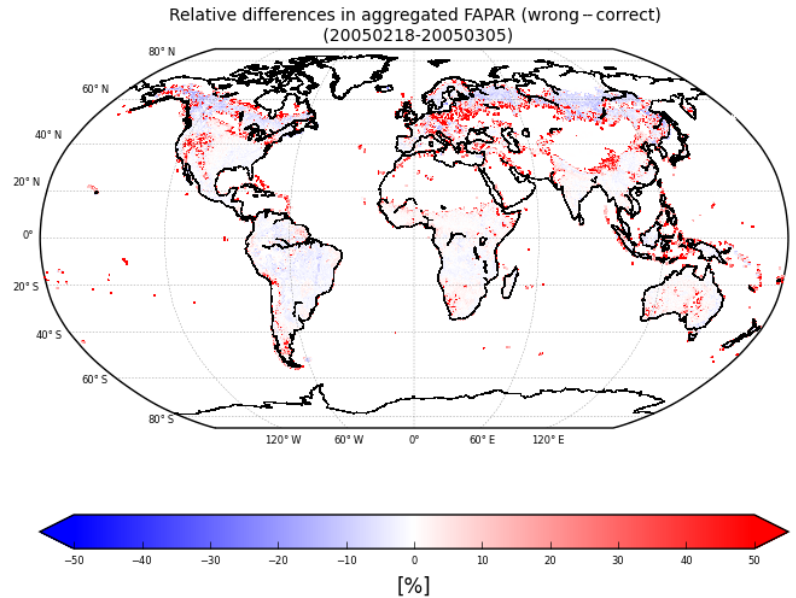
Figure 7. Relative differences of JRC-TIP FAPAR differently aggregated to 0.5 ◦ . Wrong denotes aggregation of the JRC-TIP FAPAR generated at 0.01 ◦ , whereas correct denotes aggregation of the input albedo products and subsequent application of